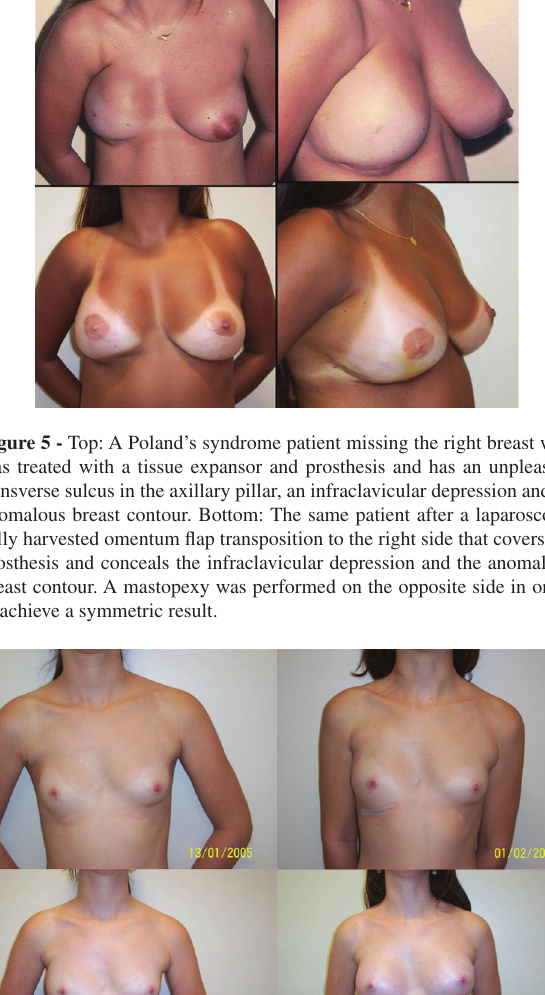
Table 2 - Short-term outcomes for thirteen patients with Poland’s syndrome treated with the omentum flap procedure.